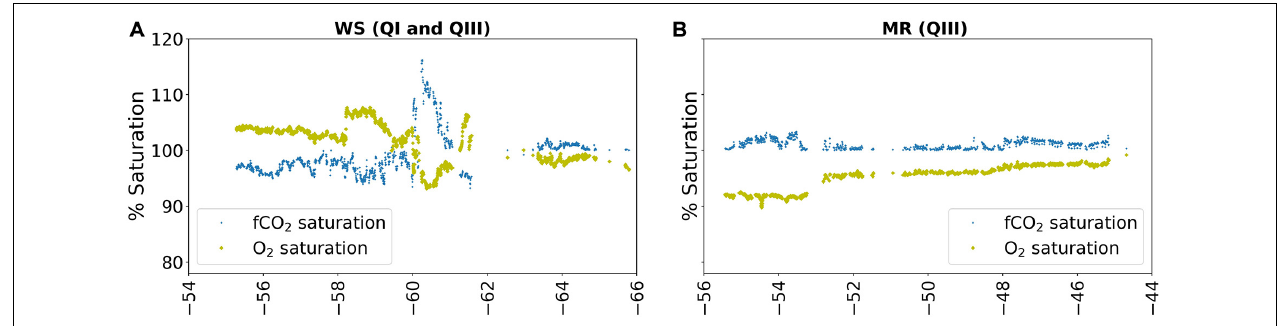
FIGURE 7 | Spatial distribution of the fCO 2 sat/O 2 sat correlations for the case waters in QI and QIII. (A) WS region and (B) MR region.